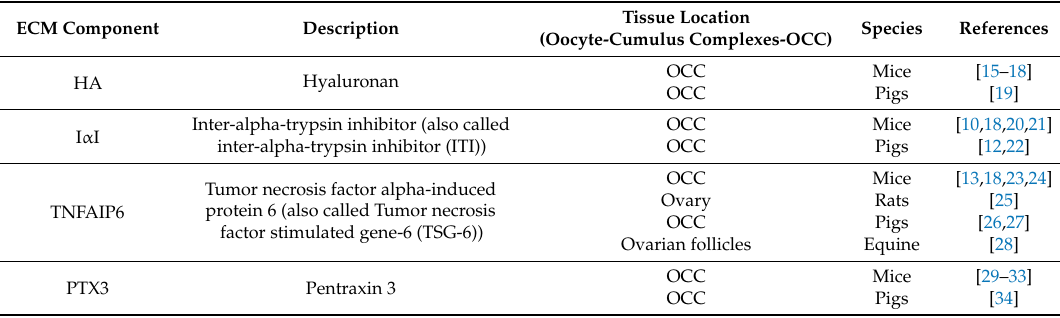
Table 1. Gonadotropin-induced matrix components essential for the formation and stability of the HA-rich oocyte-cumulus